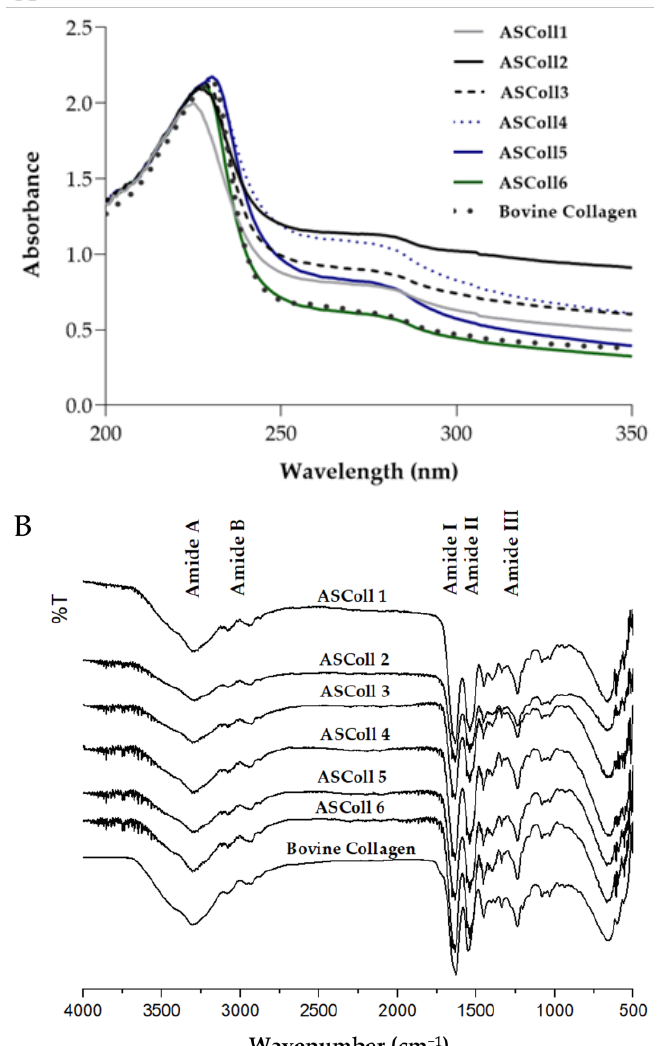
Figure 2. Chemical profile of ASColl. ( A )—Absorbance spectra of the ASColl and the commercial type I collagen from bovine skin. ( B )—Fourier transform infrared spectra of the ASColl and the commercial type I collagen from bovine skin.